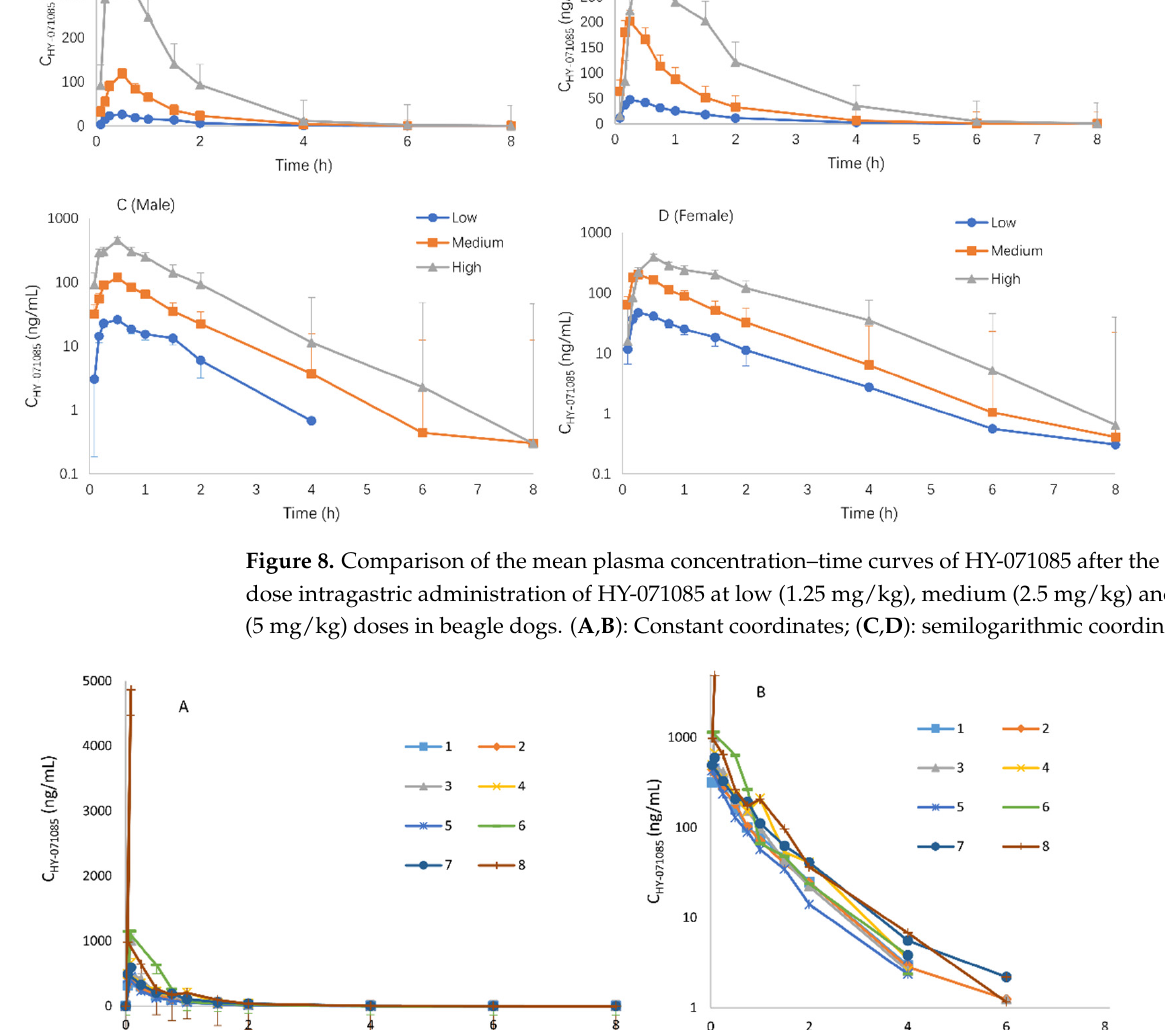
Figure 9. Mean plasma concentration–time curve of HY-071085 after the single-dose intravenous administration of 1.25 mg/kg HY-071085 in beagle dogs. ( A ) Constant coordinates; ( B ) semilogarith- mic coordinates.